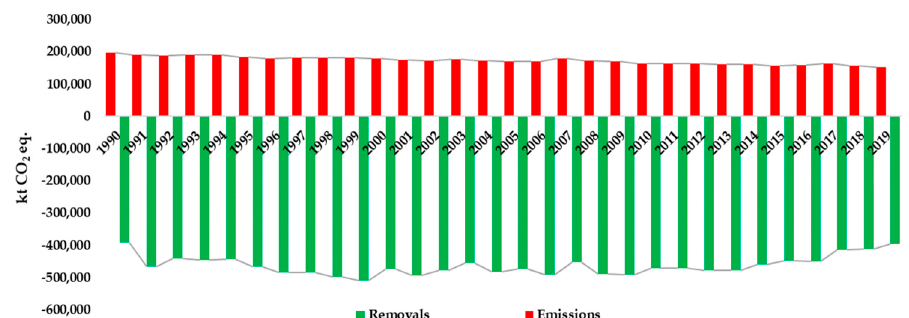
Figure 1. GHG emissions vs. GHG removals comparative dynamics, EU-27 +